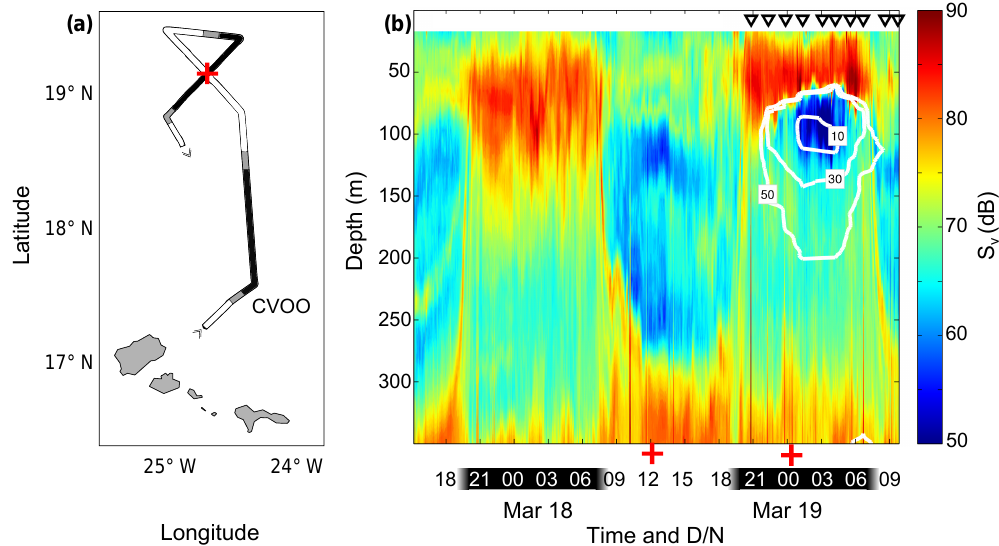
Figure 2. Cruise track with indicated day- and nighttime hours (panel a , red cross indicates intersection of day- and nighttime section) and shipboard acoustic Doppler current profiler (ADCP) mean volume backscatter S v at 75kHz (panel b , red crosses indicate the two profiles obtained at the intersection). White contour lines indicate oxygen concentrations interpolated from CTD profiles (triangles denote CTD stations).